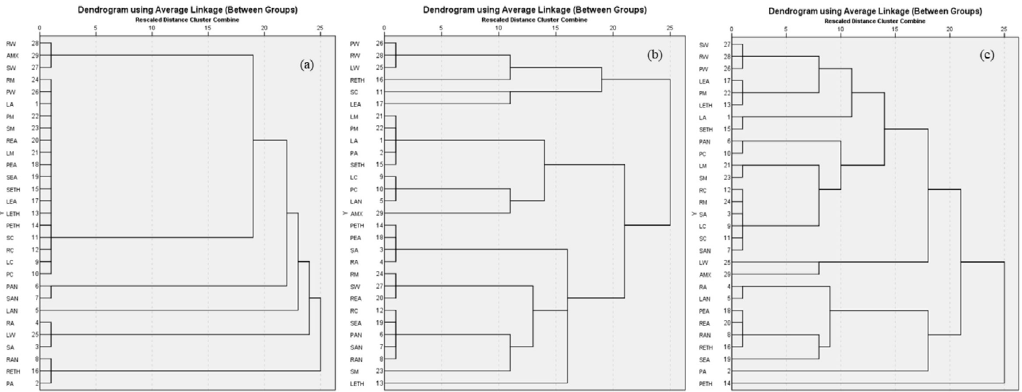
Fig. 5. Hierarchical cluster analysis of antibiofilm activity between different extracts of P. maculata against (a) S. aureus (b) K. pneumoniae and (c) P.